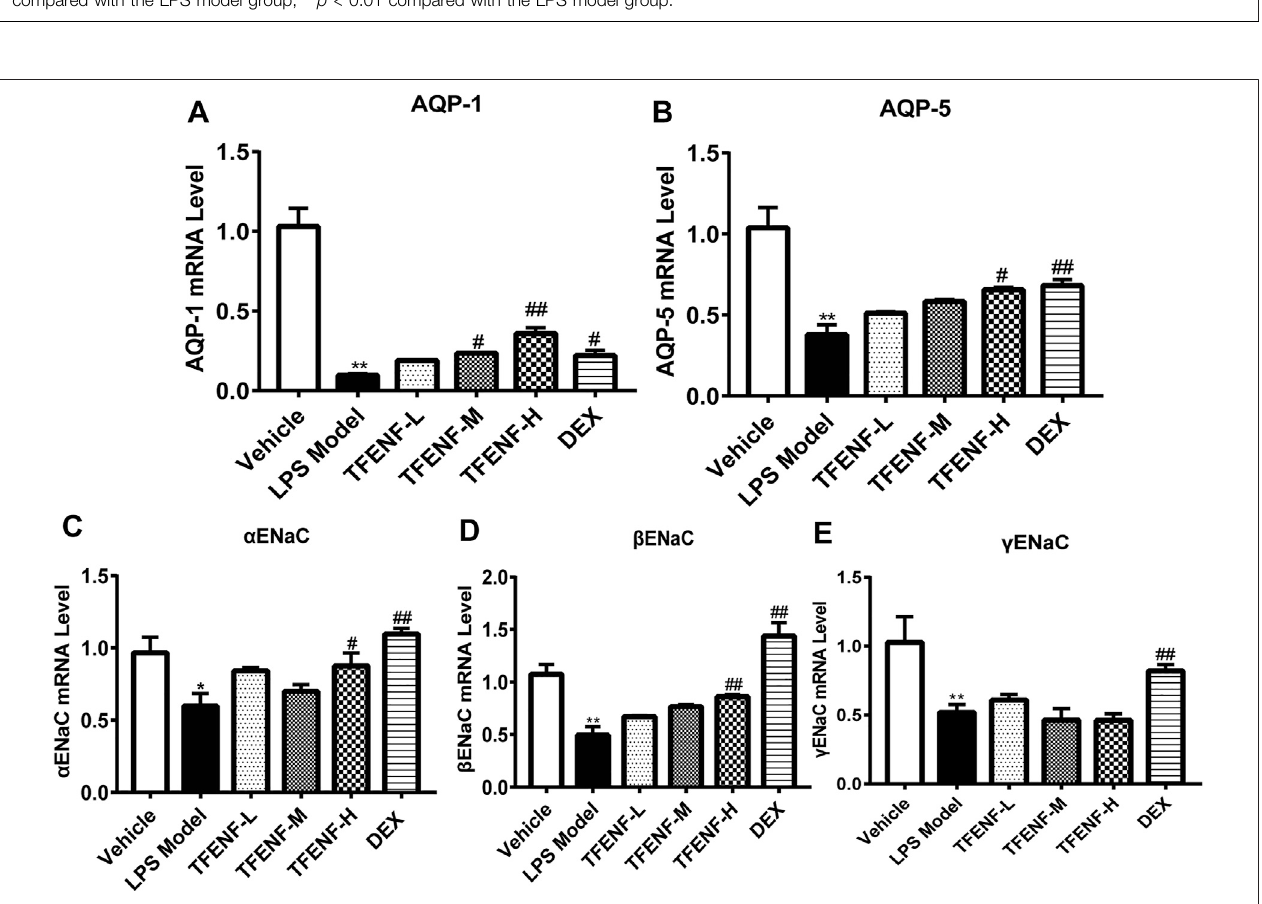
FIGURE 6 | TFENF increased the mRNA expression of AQPs and ENaC in LPS-induced ALI. mRNA expression of AQP-1 (A) , AQP-5 (B) , α ENaC (C) , β ENaC (D) , and γ ENaC (E) in lung tissue 6 h after LPS-induced ALI or saline treatment ( n (cid:2) 6 per group). Data are presented as mean ± S.E.M. *p < 0.05 compared with the vehicle group; **p < 0.01 compared with the vehicle group; # p < 0.05 compared with the LPS model group; ## p < 0.01 compared with the LPS model group.